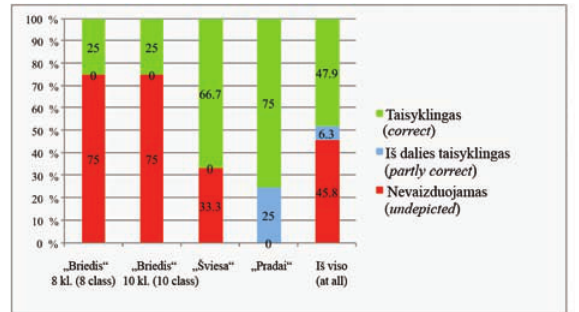
Fig. 4 . Taxonomic differentiation in the legends of the analysed economic maps of scholastic geographical